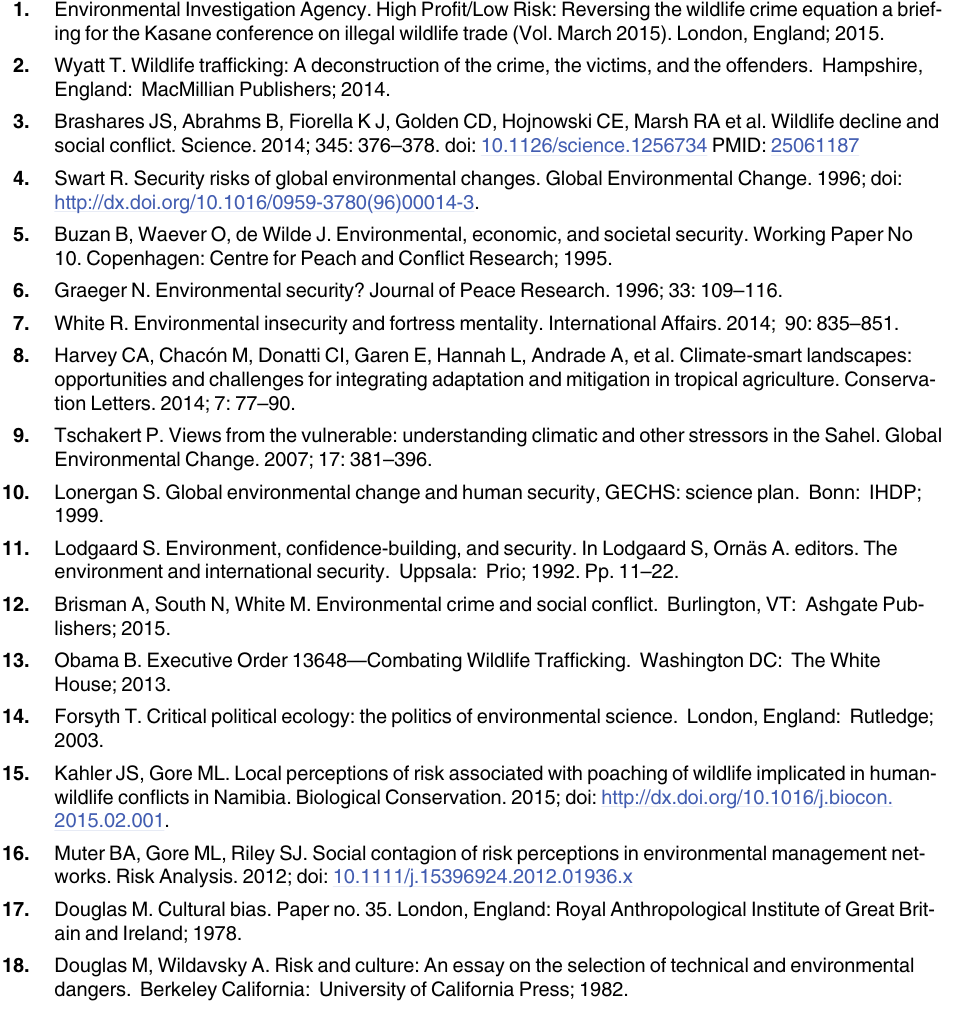
S1 File. Supporting Information. Figure A. Interview instrument. Table A. New variables cre- ated for